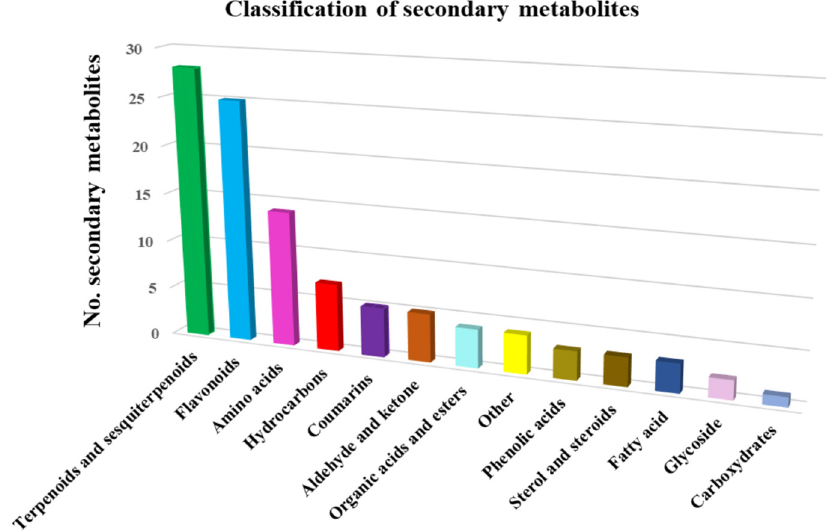
Figure 3. Artemisia annua metabolite classification